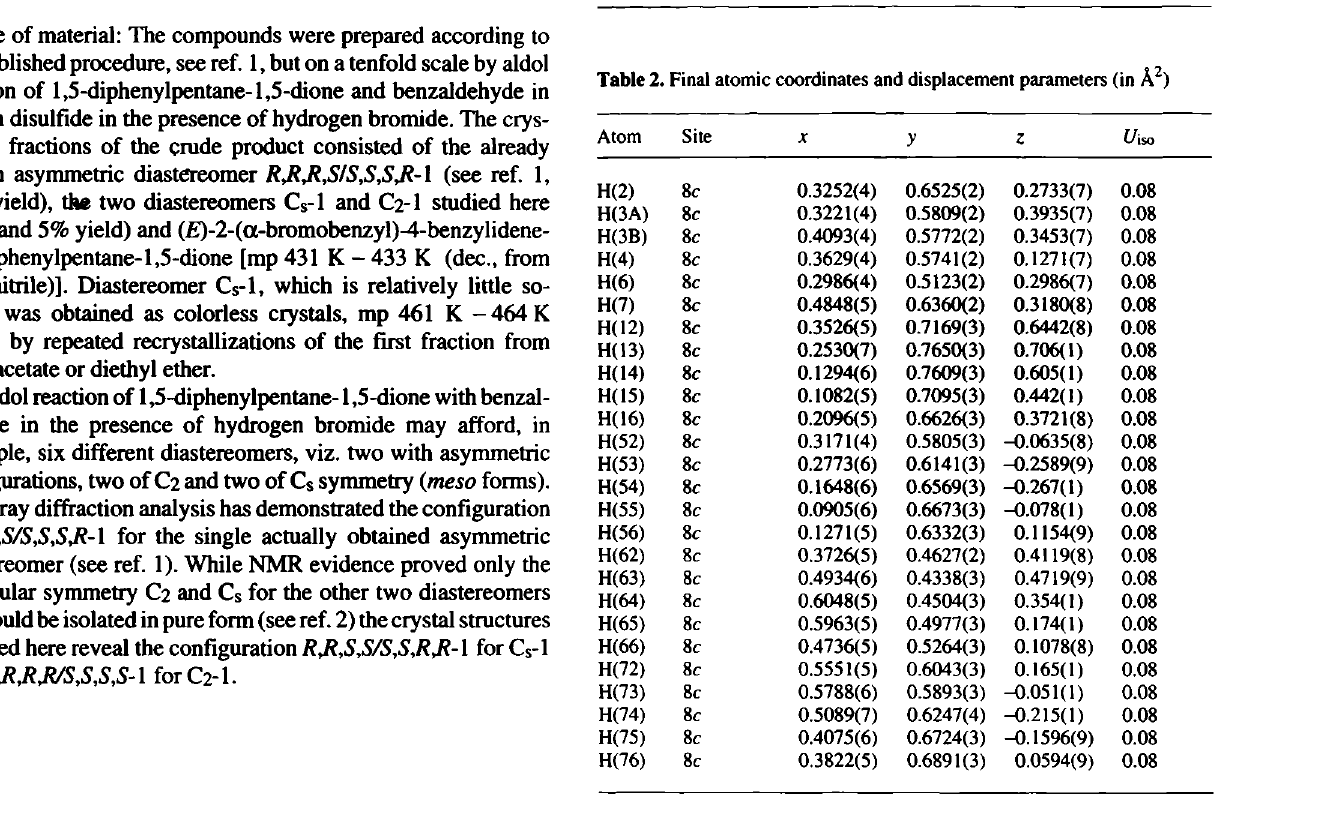
Table 1. Parameters used for the X-ray data collection Crystal: